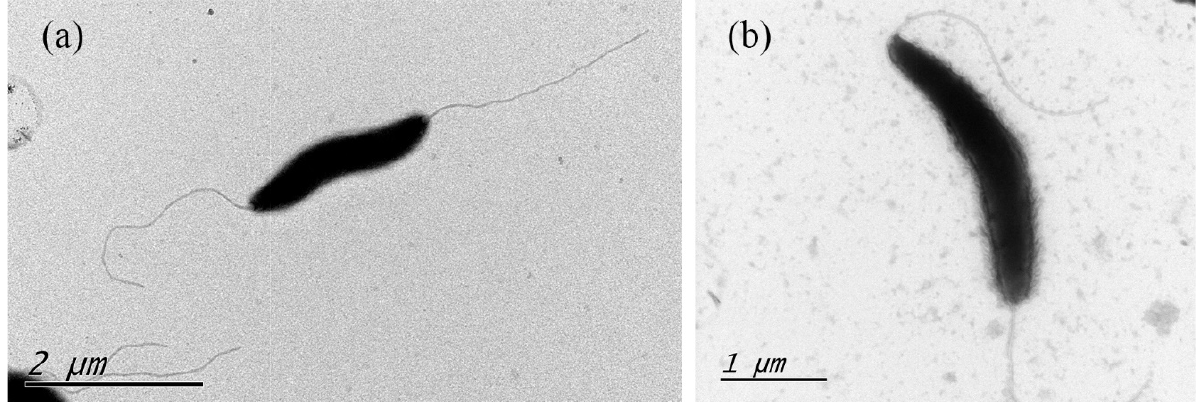
Figure 1. Transmission electron microscope image of the novel Campylobacter strains from 48 h culture. ( a ) C. felis strain XJK22-1 T . ( b ) C. ovis strain SYS25-1 T . Like most other Campylobacter species, the isolates were positive for oxidase and negative for urease activities. The catalase was negative for species of type strain XJK22- 1 T and positive for species of type strain SYS25-1 T . While most Campylobacter species are unable to hydrolyze hippurate and able to hydrolyze indoxyl acetate and reduce nitrate, two-thirds ( n = 6, XJK22-1 T , XJK33-1, XJK49-2, XJK56-3, XJK62-3, and XJK7-1) of the new species isolates were able to hydrolyze hippurate and indoxyl acetate positive and could reduce nitrate, and the other one-third ( n = 3, S13-1, SYS25-1 T , and SYS28-3) could not hydrolyze hippurate and indoxyl acetated, among which only two isolates could reduce nitrate ( n = 2, S13-1 and SYS25-1 T ). There are only five other species of the genus Campylobacter , C. avium , C. curvus , C. jejuni , C. hepaticus , and C. geochelonis that